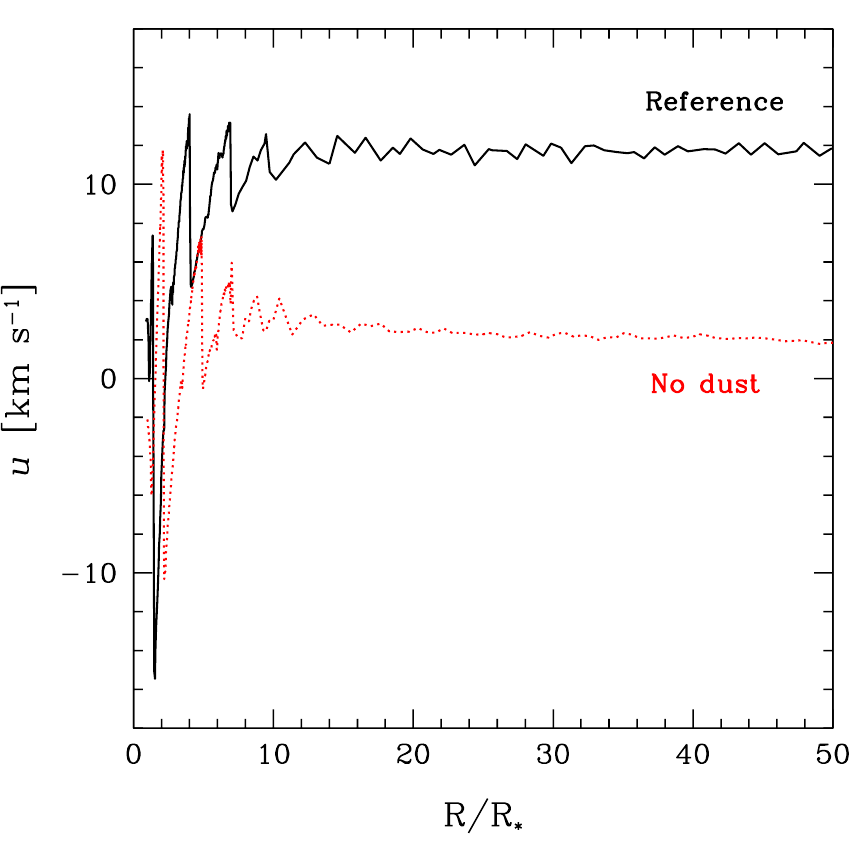
Figure 6. Velocity profiles as a function of the radius coordinate for the Reference model and for the model without